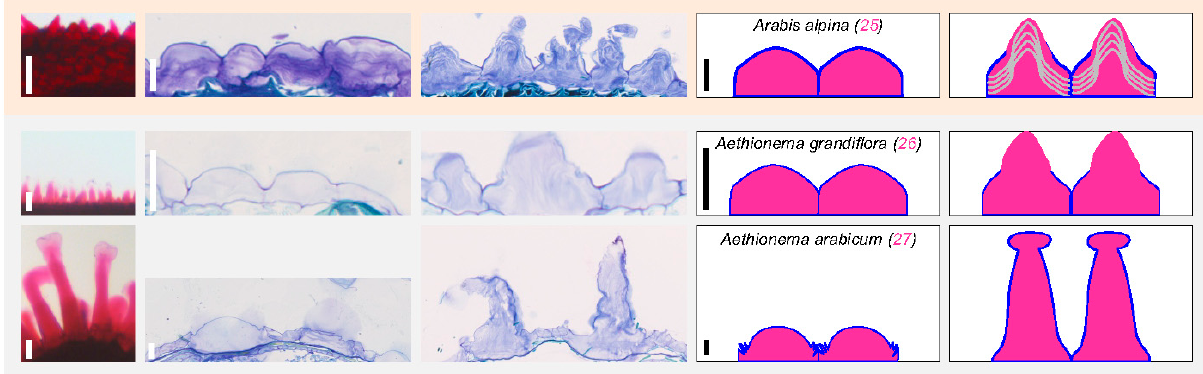
Figure 5. Lineage 4 and early diverging studied species display large MSCs forming a spiny-shaped mucilage upon imbibition. Column 1: magnified view of imbibed seeds stained with ruthenium red (full images are shown in Figure 2) reminds the ability to release mucilage or not. Scale bar: 100 µm. Columns 2 and 3: Toluidine blue histochemical staining of dry seeds and imbibed seeds, respectively, focusing on the MSC morphology and of mucilage release. Note that the inner part of the seed is located below the imaged cells. Scale bar: 25 µm. Columns 4 and 5: simplified drawings of two epidermal cells at the same scaling shown in Toluidine blue images. For each line the species name, the species number (pink for myxospermous species), as well as the scale of cross sections is reminded in column 4. A color code is applied for mucilage (pink), primary wall (blue), columella or columella-like structure (green), intracellular unidentified structures or sublayering (grey).